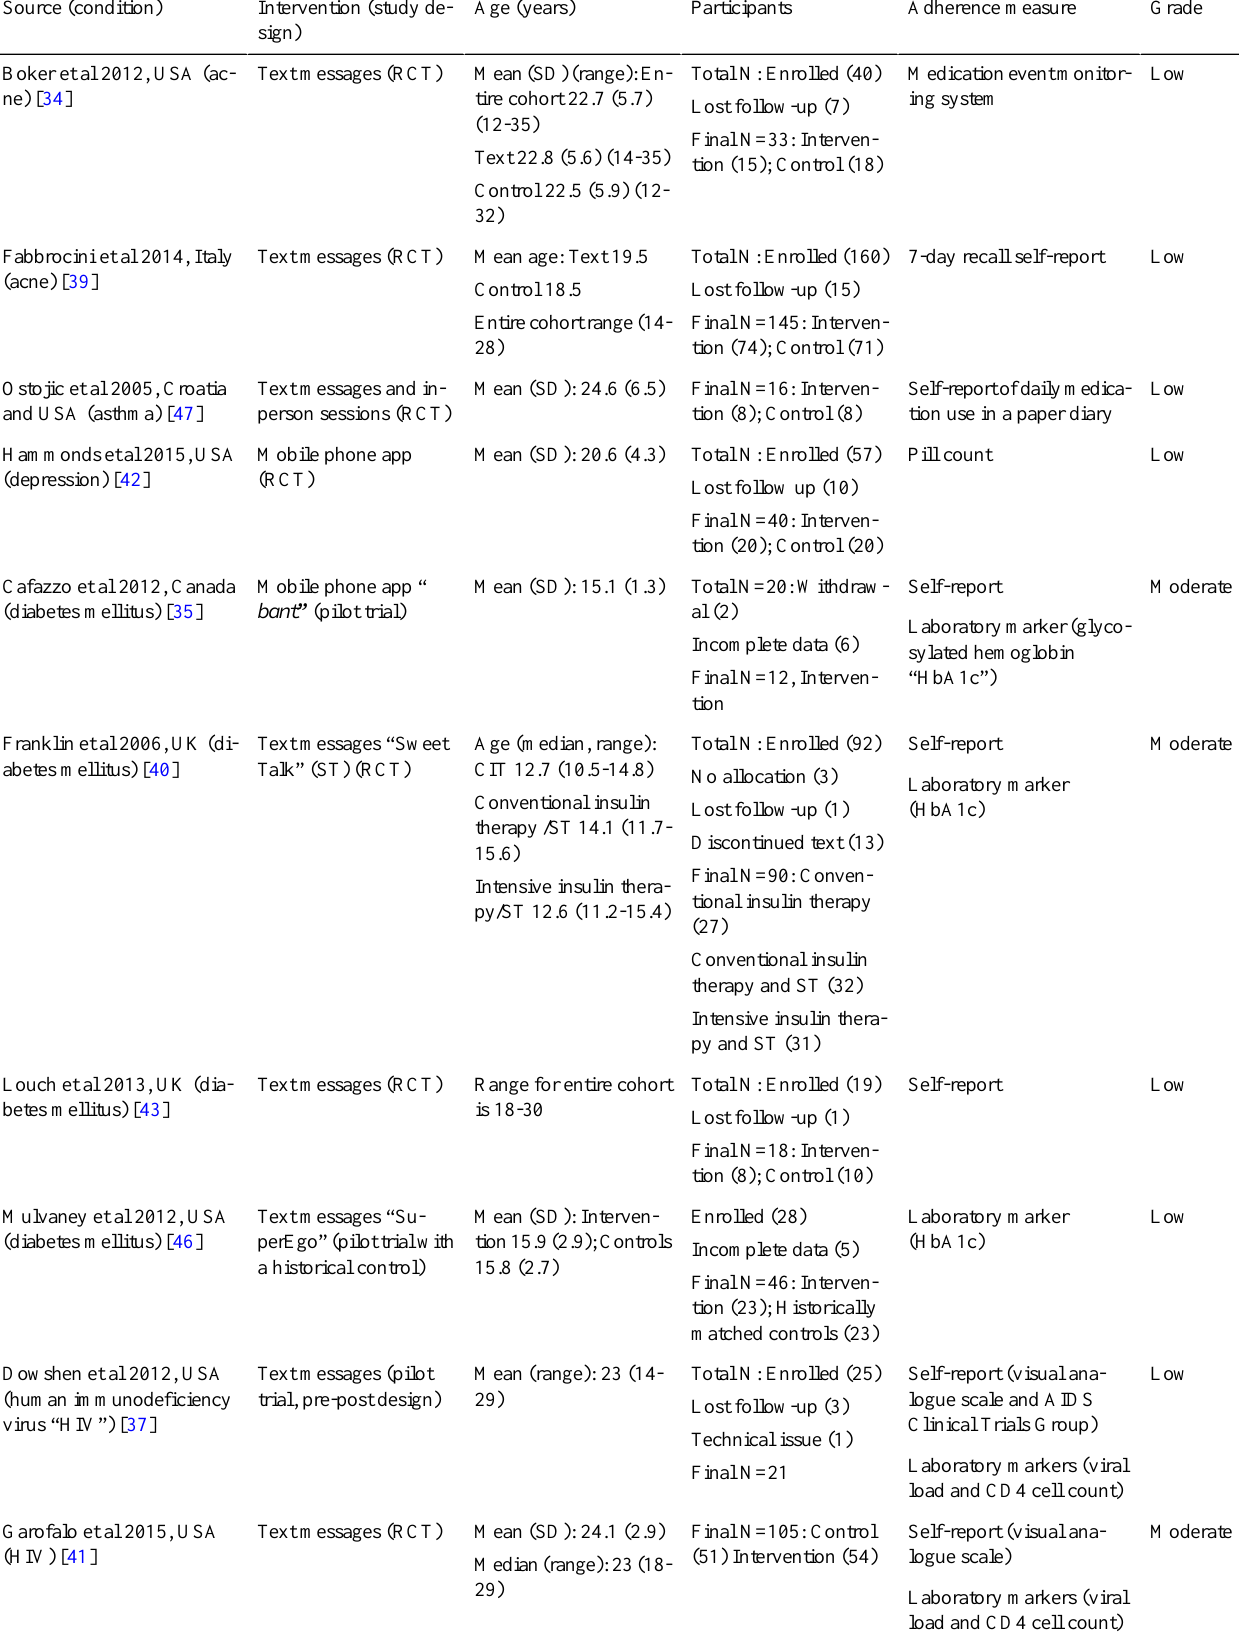
Table 1. Summary of included studies that focused on improving adherence in adolescents with CHCs using text message or mobile phone app